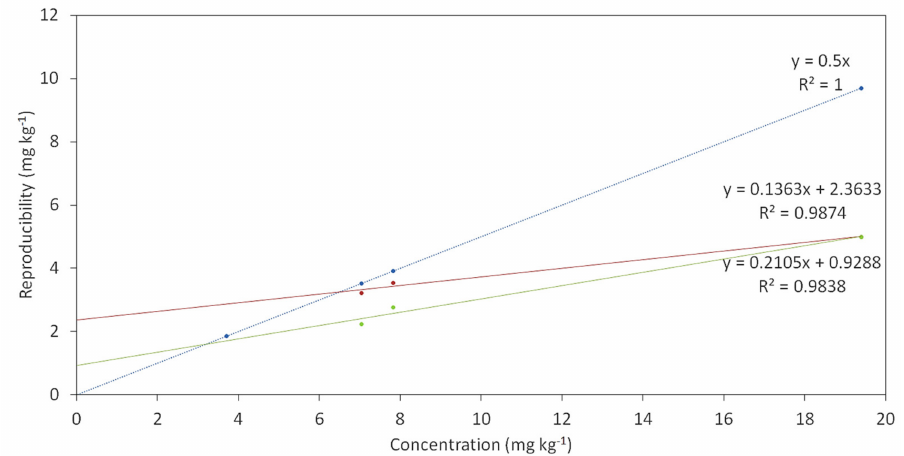
Figure A1. Detected Cr(VI) concentration (mg kg − 1 ) of a Cr(III), Cr(VI) and gelatine solution vs. extraction time (minutes) ( a ), UV spectra of the same solution after 300 min: with DPC (Blue), without DPC (Red) ( b ).